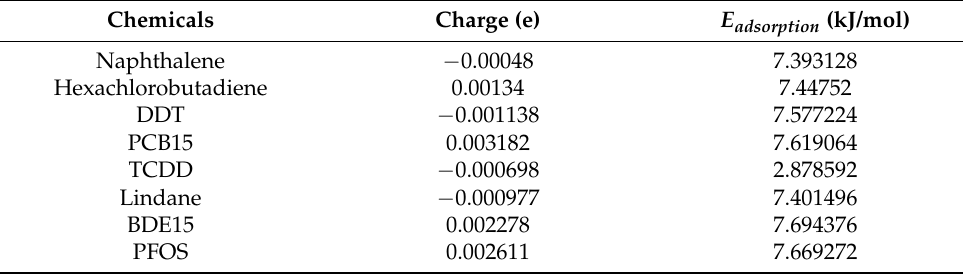
Table 3. Molecular doping and adsorption energy of